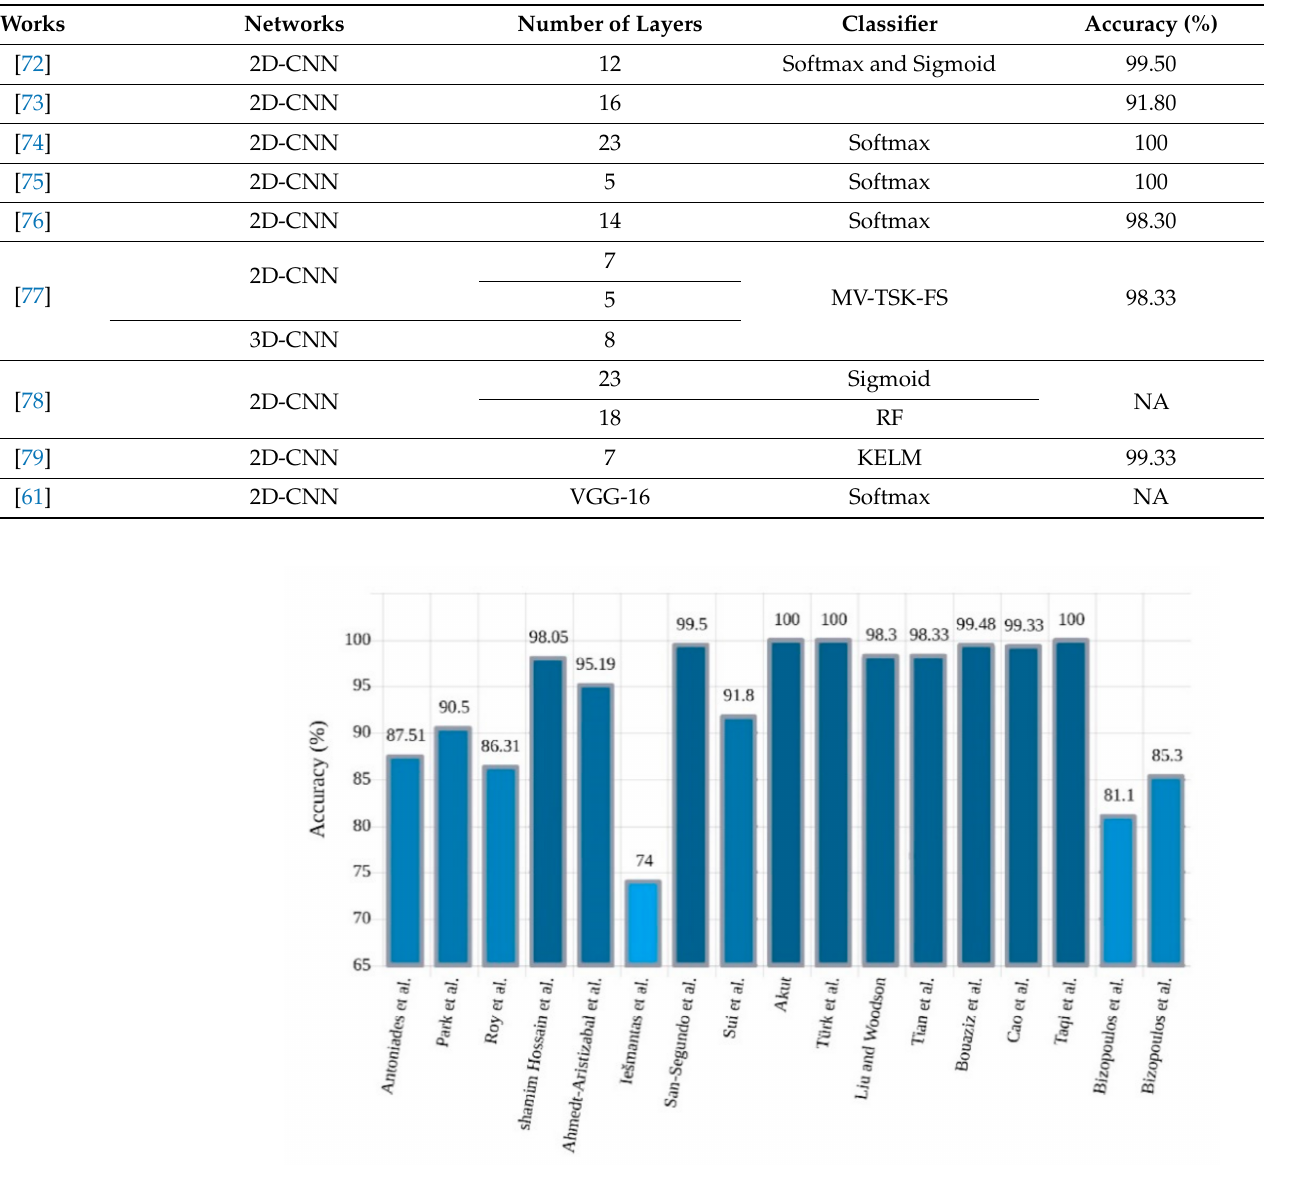
Figure 7. Sketch of accuracy (%) obtained by various authors using 2D-CNN models for seizure